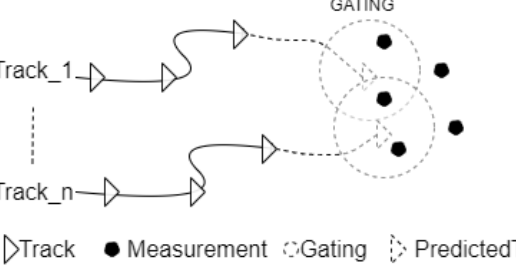
Figure 7. The Gating